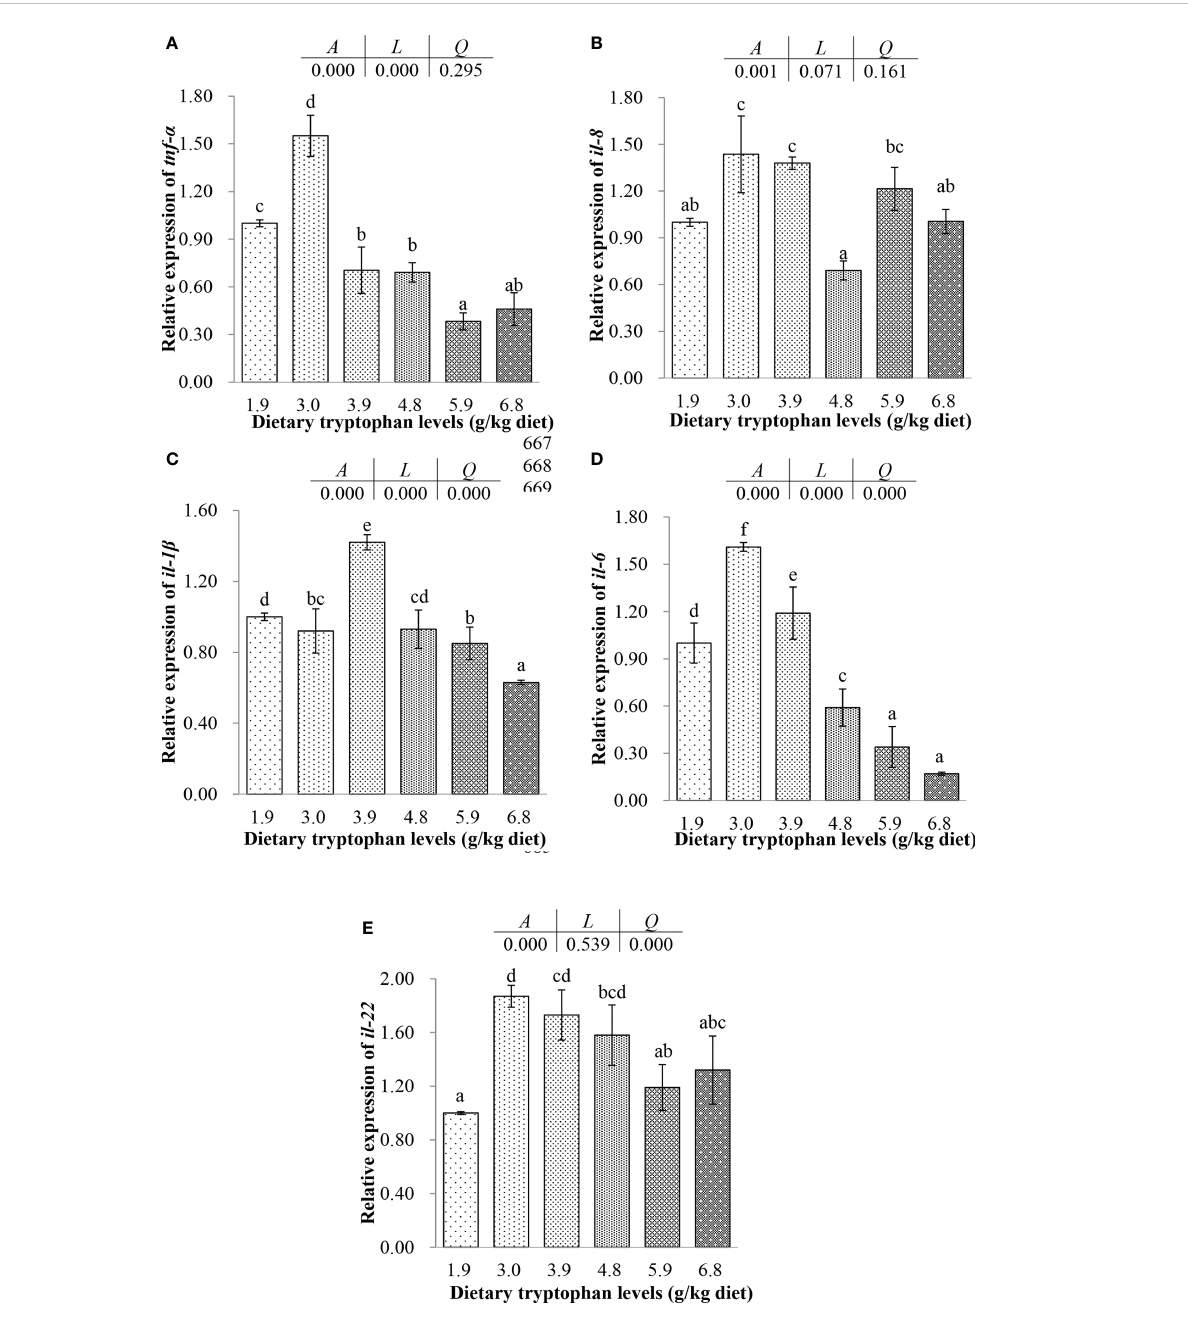
FIGURE 3 Effects of dietary tryptophan with different levels on the relative mRNA expression of genes related to intestinal in fl ammatory factors of C argus (means ± S.D. of three replications). Bars with different letters differ signi fi cantly among the treatments ( P < 0.05). (A) Tumor necrosis factor a ( tnf- a ); (B) Interleukin 8 ( il-8 ); (C) Interleukin 1 b ( il-1 b ); (D) Interleukin 6 ( il-6 ); (E) Interleukin 22 ( il-22